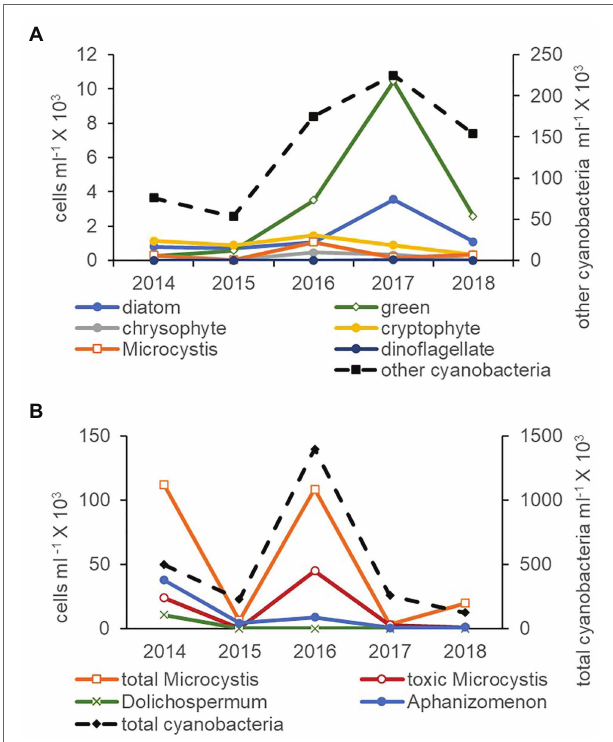
FIGURE 3 | Average abundance of natural units for other cyanobacteria (non- Microcystis , secondary axis), Microcystis and phytoplankton measured by the inverted microscope technique (A) and total cyanobacteria (secondary axis), Microcystis and toxic cyanobacteria single cells measured by qPCR (B) for July through November between 2014 and 2018. Note the different axes